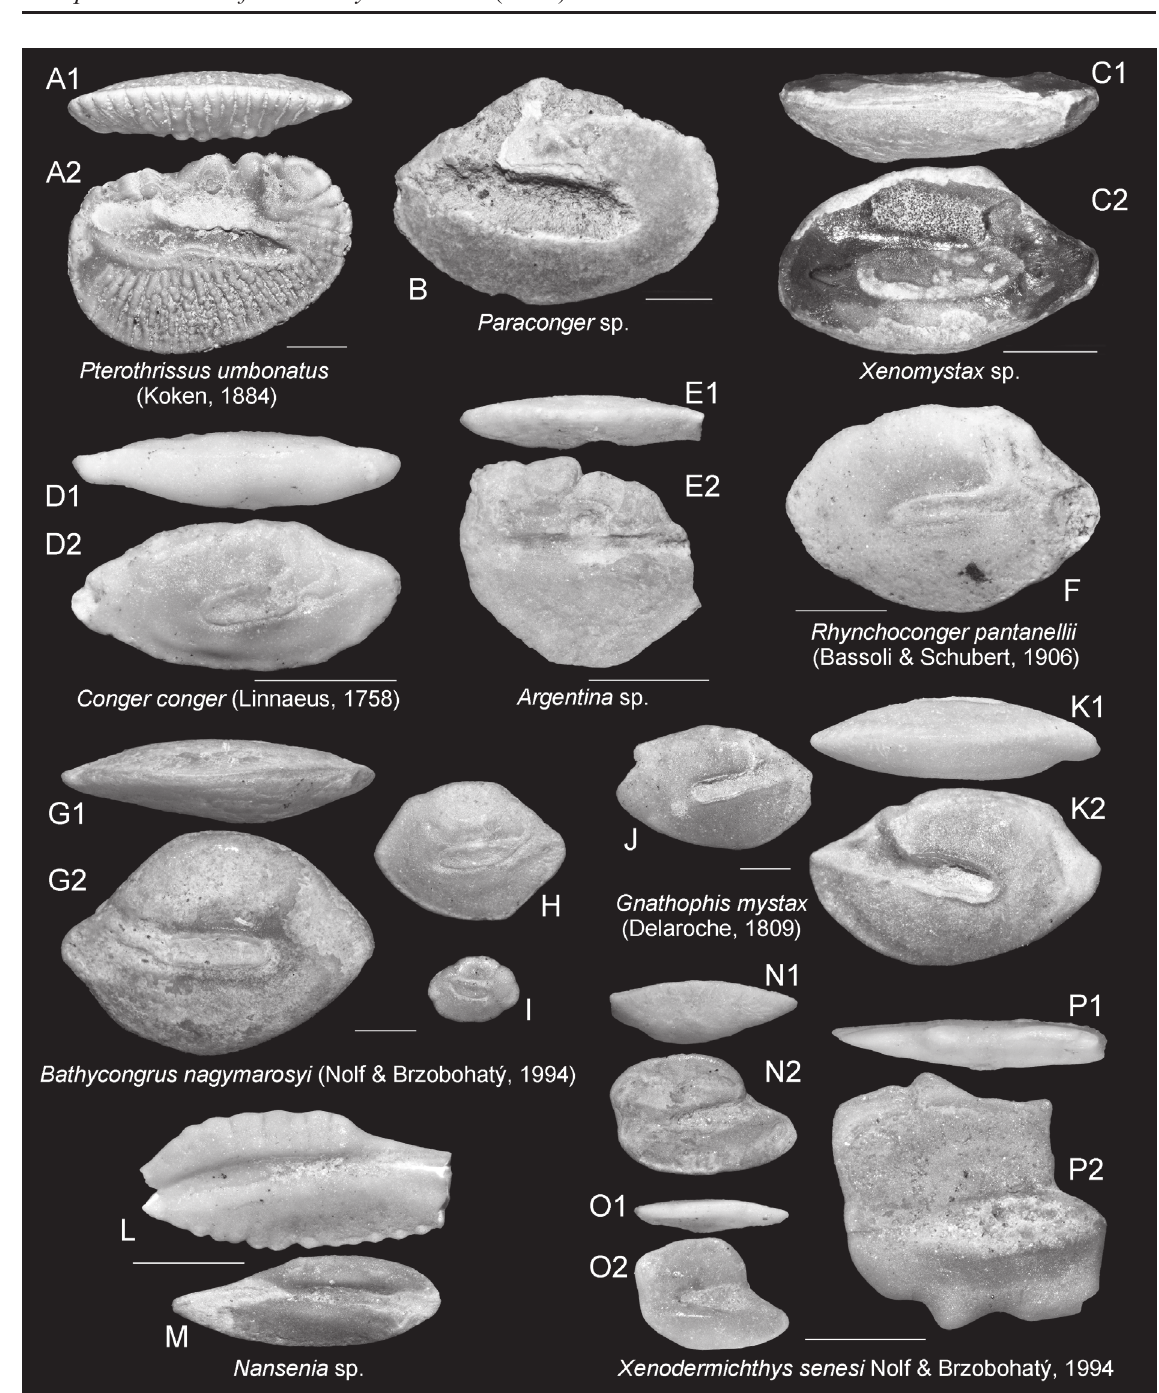
Fig. 2. Tortonian fish otoliths from northern Italy. A . Pterothrissus umbonatus (Koken,